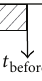
Figure 7: No upstream transmission between two downstream